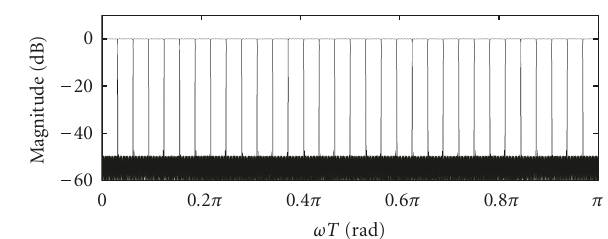
Figure 13: Magnitude responses of the analysis filters with separate optimization for M = 32, Example 2.